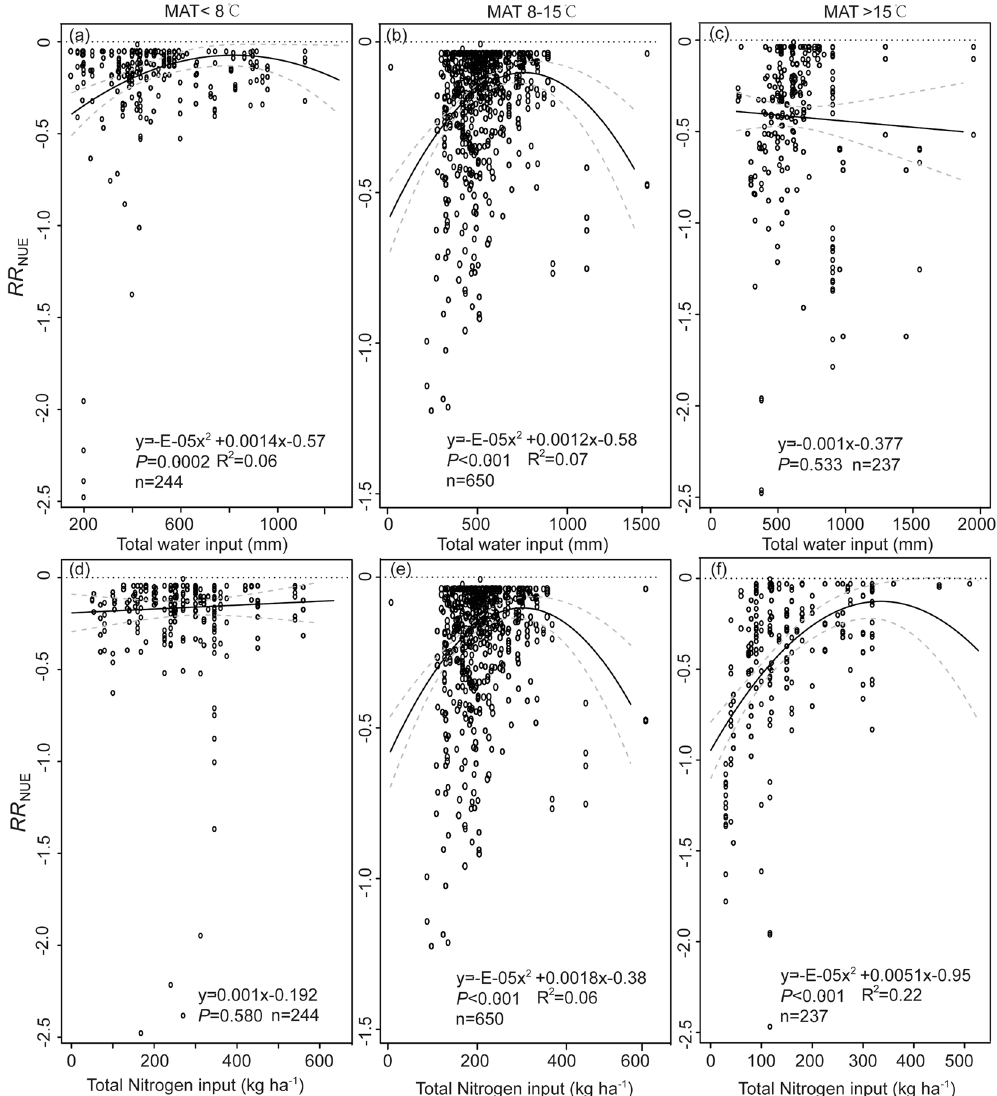
Figure 6. Scatter plot of response ratio of nitrogen use efficiency ( RR NUE ) to water input when mean annual temperature (MAT) is ( a ) < 8 °C, ( b ) 8–15 °C, or ( c ) > 15 °C; to nitrogen input when MAT is ( d ) < 8 °C, ( e ) 8–15 °C, or ( f ) > 15 °C. Response ratio stands for effect size between the treatment and control and is calculated using Eq. 4. The solid black line represents the weighted regression line based on variance-weighted least squares. The grey line shows the 95% CI around the regression line. The circles indicate the response ratio of each observation. The circle size is proportional to the precision of the response ratio. Note the different scales among the